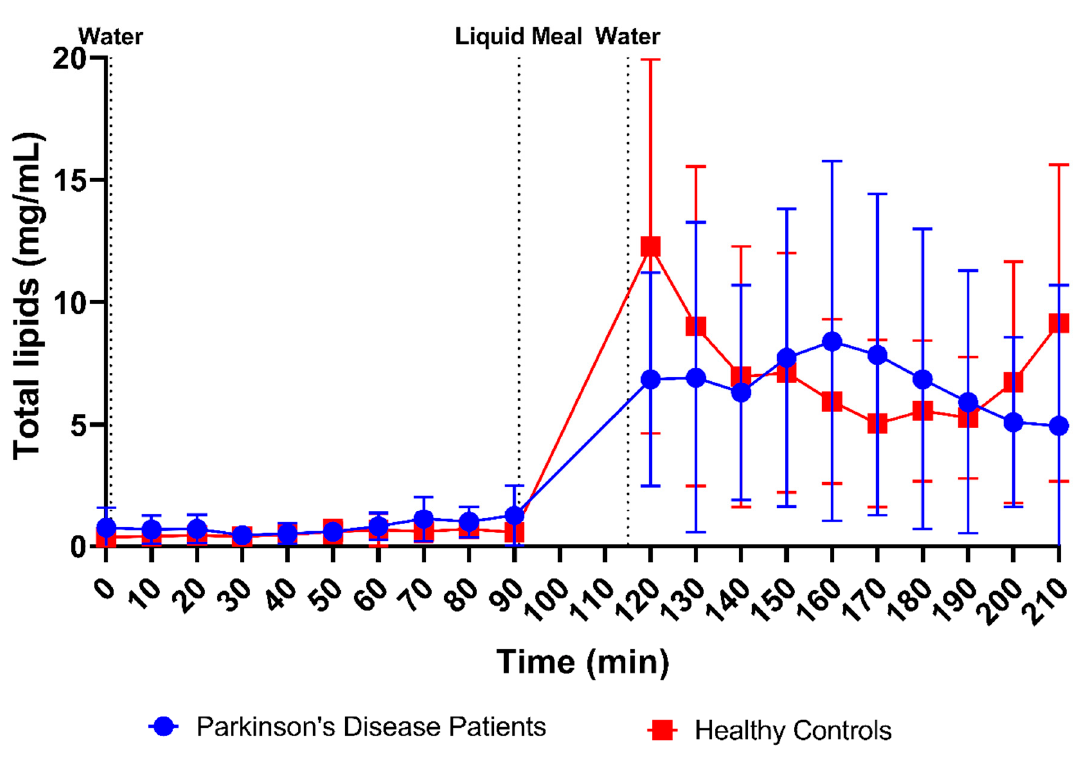
Figure 13. Time-dependent evolution of the total lipid concentration in duodenal fluids aspirated from Parkinson’s disease patients ( n = 9, blue circles) and healthy controls ( n = 9, red squares). Data points represent the mean ± standard deviation; vertical dotted lines indicate the ingestion of 100 mL of water or 200 mL of liquid meal.